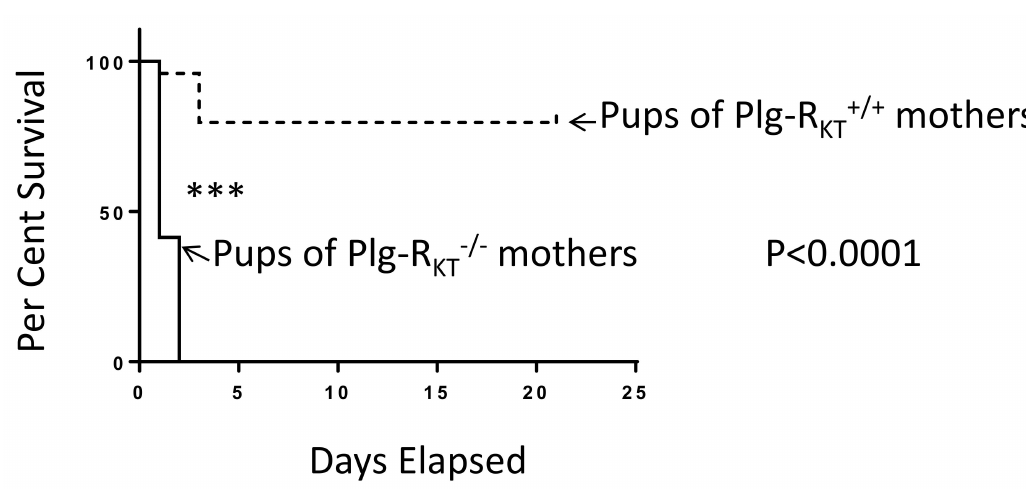
Figure 5. Plg-R KT null mice cannot successfully lactate. Survival data are shown for a cohort of offspring of Plg-R KT+/+ (dashed lines) and Plg-R KT − / − (solid lines) primiparous female littermates: 48 offspring of Plg-R KT+/+ mice and 30 offspring of Plg-R KT − / − mice. **** p < 0.0001 Log-rank (Mantel Cox test). This research was originally published in Miles, L.A.; Baik, N.; Bai, H.; Makarenkova, H.P.; Kiosses, W.B.; Krajewski, S.; Castellino, F.J.; Valenzuela, A.; Varki, N.M.; Mueller, B.M.; Parmer, R.J. The plasminogen receptor, Plg-RKT, is essential for mammary lobuloalveolar development and lactation. J. Thromb. Haemost. 2018 , 16 , 919–932 [83], and is reprinted with permission from John Wiley and Sons.